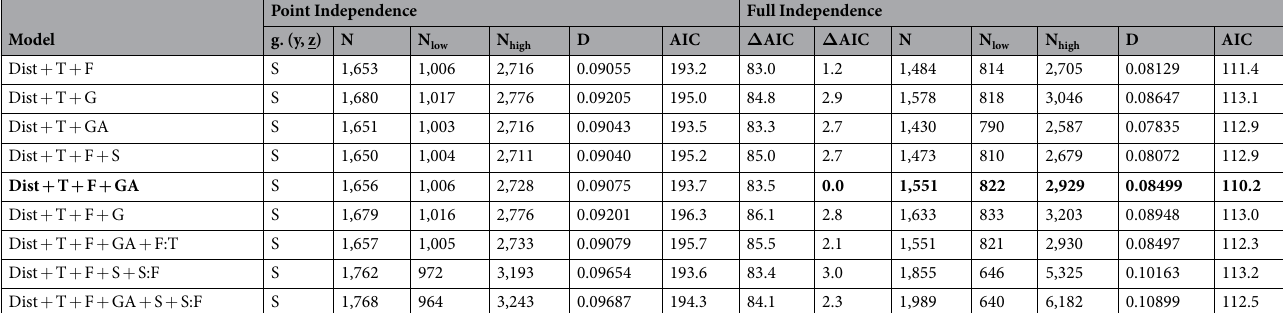
Table 2. Point Independence (PI) and Full Independence (FI) model details and selection results for the Mark- Recapture Distance Sampling analysis of bottlenose dolphin dual observer data; The model for the conventional detection function g. (y, z) is only relevant in the PI scenario; The best model (selected based on the AIC scores) is shown in bold; along with eight other models that had AIC values within three of the best model; Details for all 38 models are shown in Supplementary table S1; Covariate terms are as follows: Dist = distance, F = fatigue, G = glare intensity, GA = glare angle, S = group size, T = time of day. Colons “:” code for variable